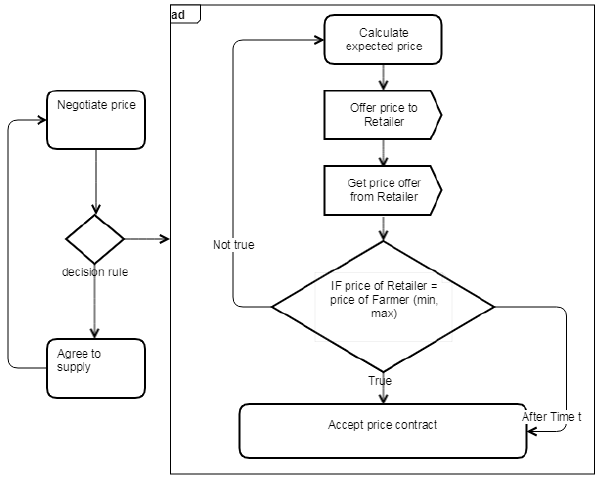
Figure 8. Example of decision rules for processor selling to retailer.